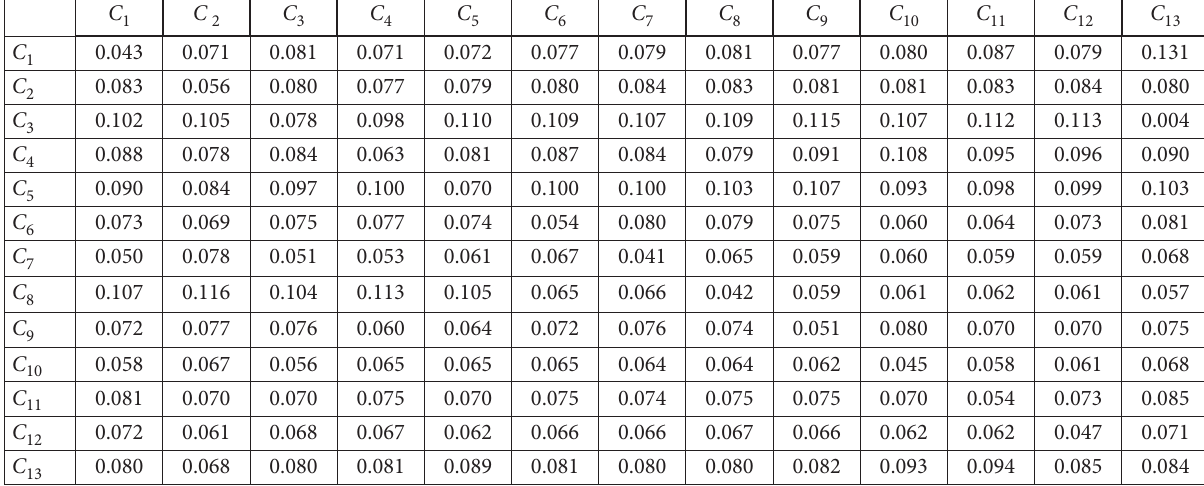
Table 8. Weighted